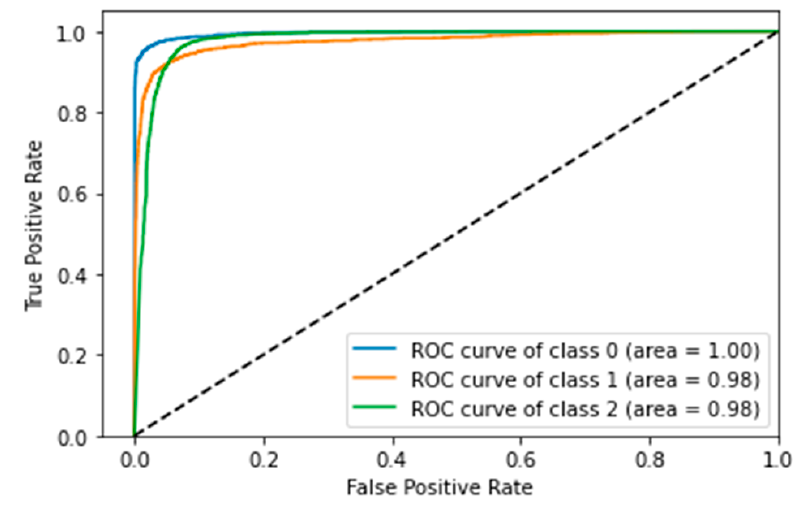
Figure 15. ROC curve for MobileNetV2 model. The ROC curve for Xception model is shown in the Figure 16.